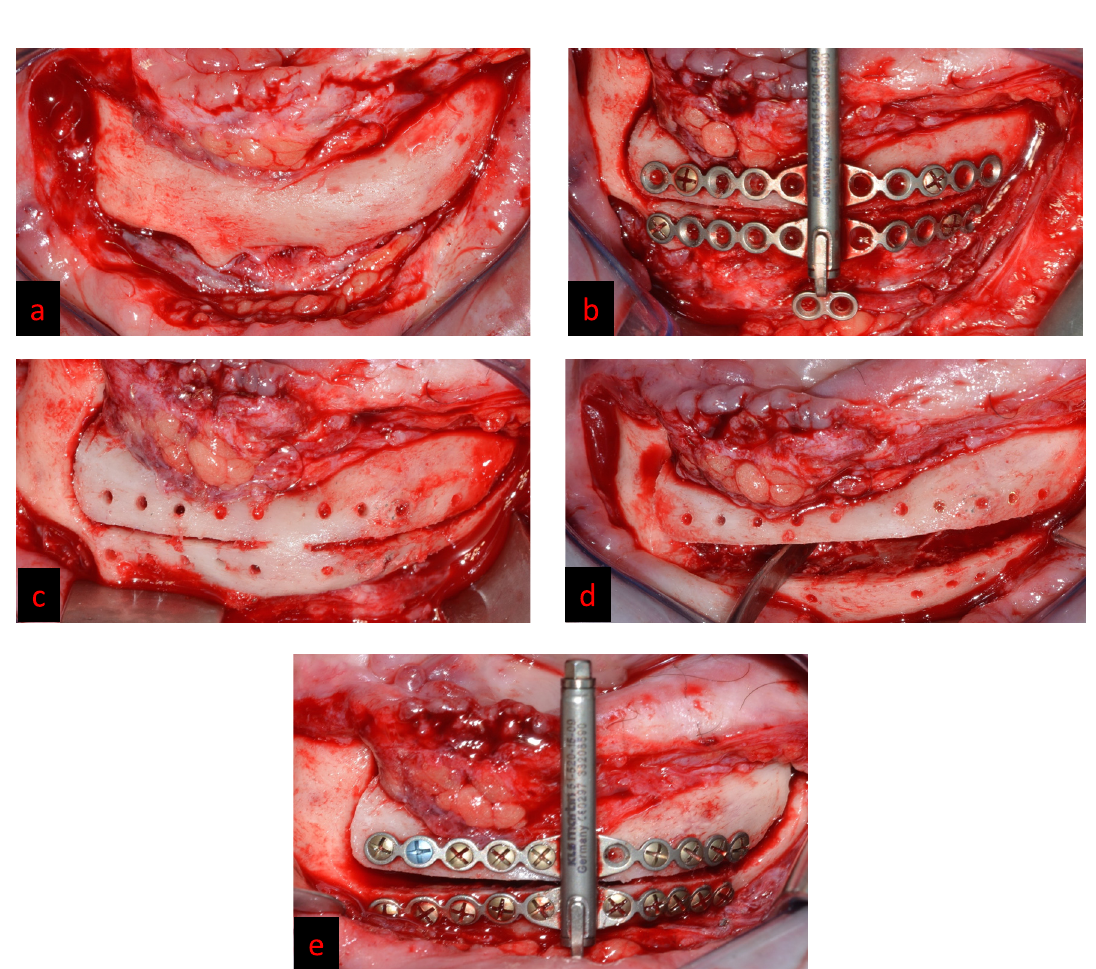
Fig. 4. (a) Buccal incision (cid:1) elevation of a full thickness vestibular fl ap with preservation of lingual mucoperiosteal attachment. (b) Two divergent vertical and one horizontal osteotomy are performed using Piezosurgery. (c) Distractor is removed to fi nalize the osteotomies. (d) Transport bone fragment is mobilized. (e) Distractor fi xed into his initial